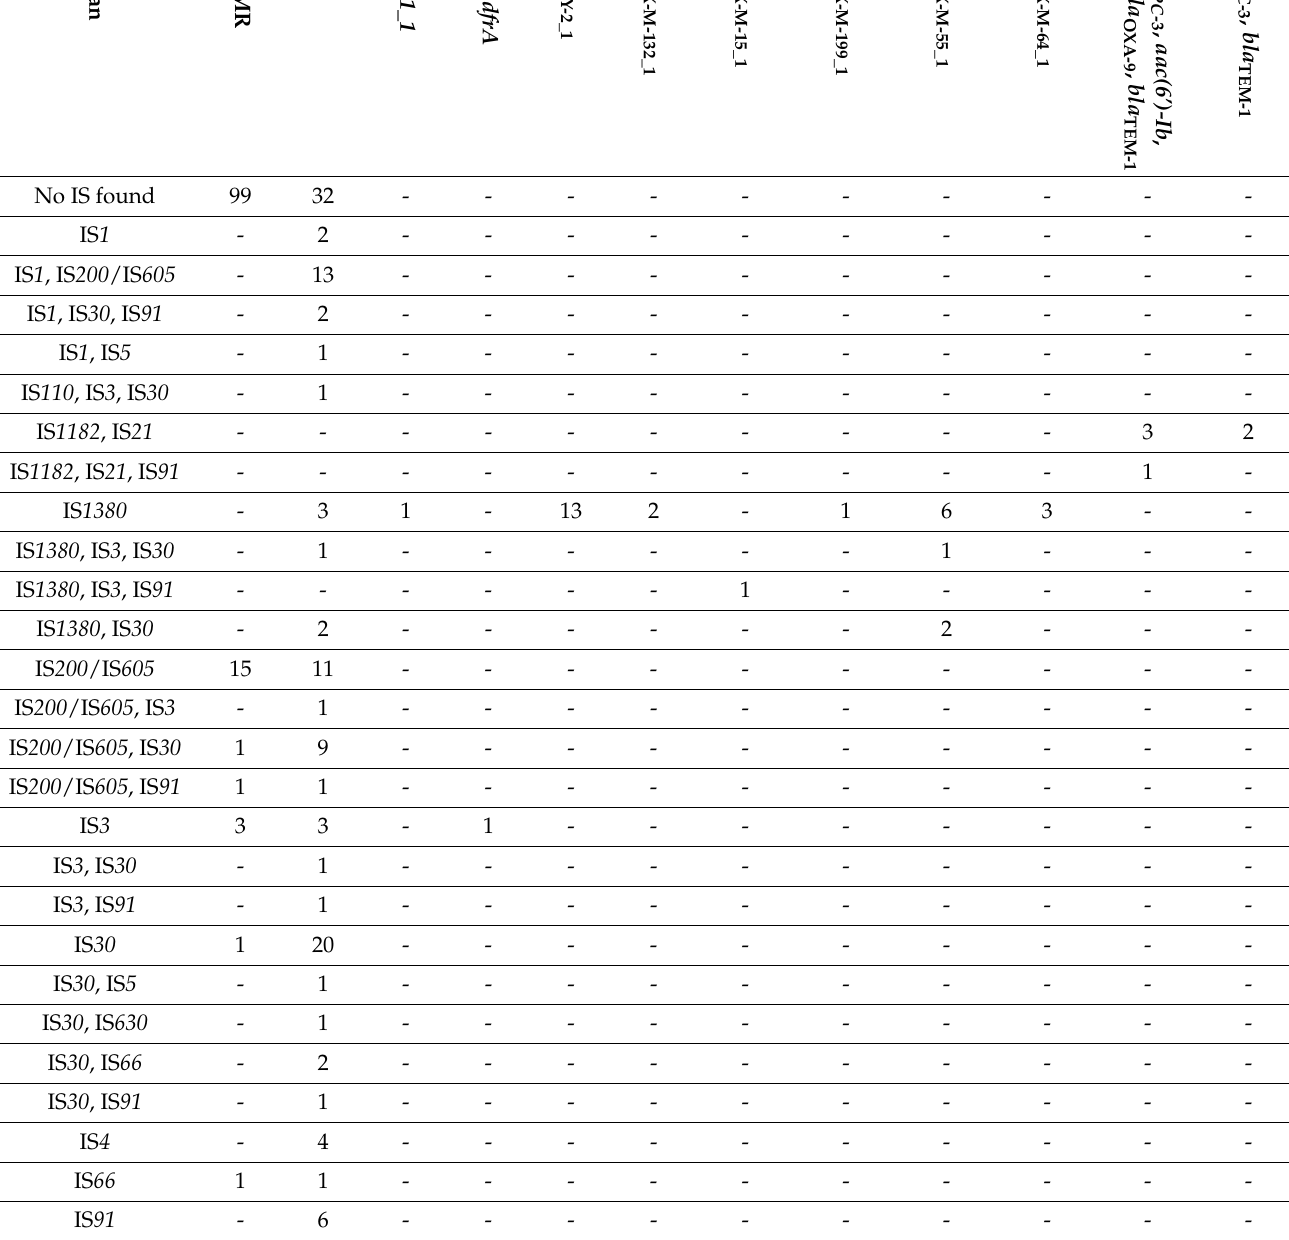
Table 1. Distribution of IS elements in global collection of IncI2 plasmids correlated with carriage of resistance